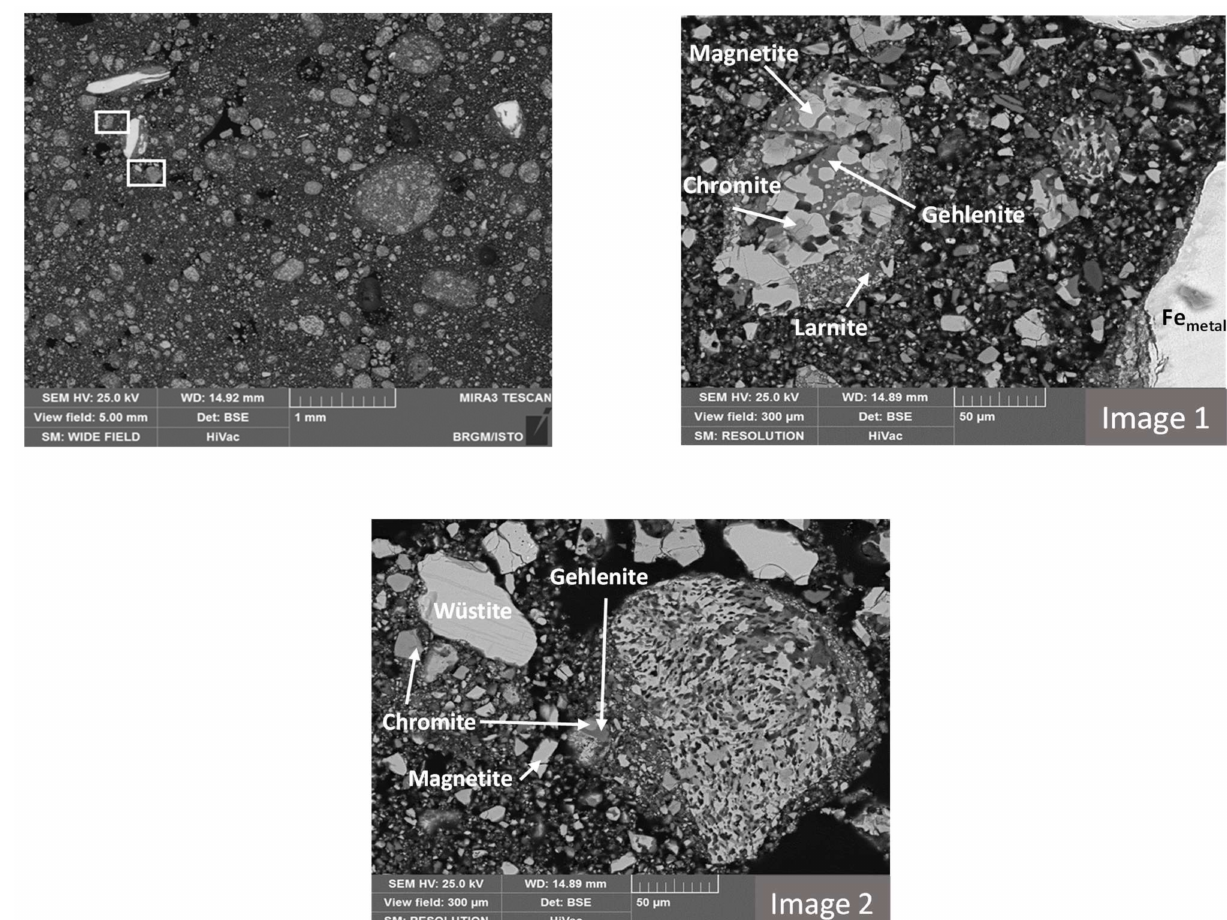
Figure 6. Textural aspect of the magnetic fraction of the +0.25–1 mm-sized fraction with the location of two detailed mineralogical images (white